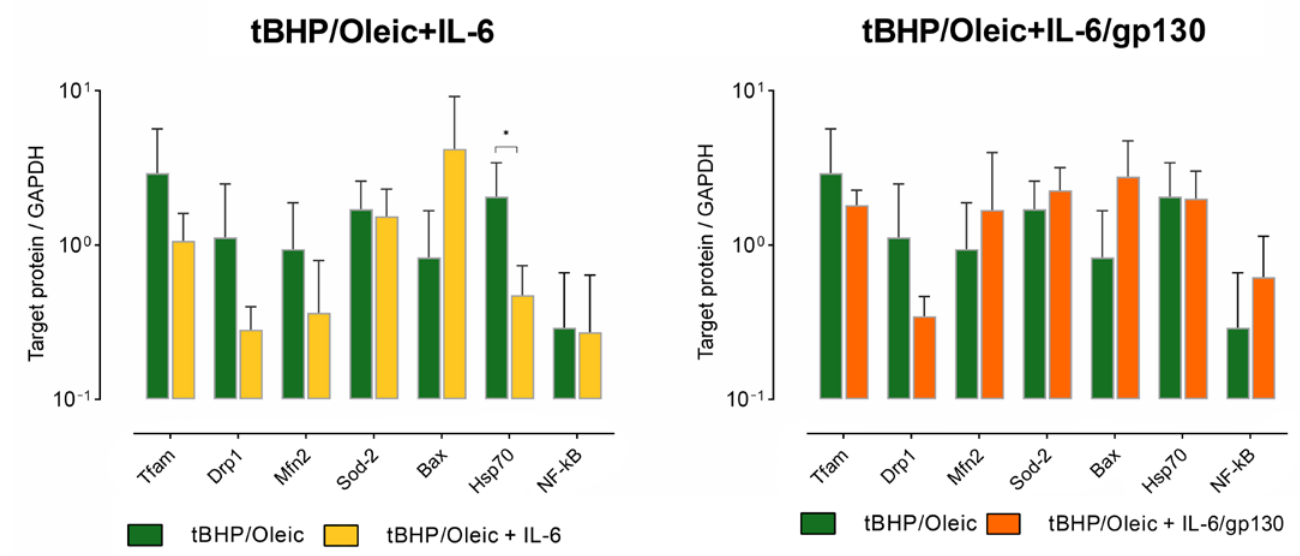
Figure 6. Protein production levels in HepG2 cell models with the addition of IL-6 and gp130. (Mean ± SD), *— p < 0.05.